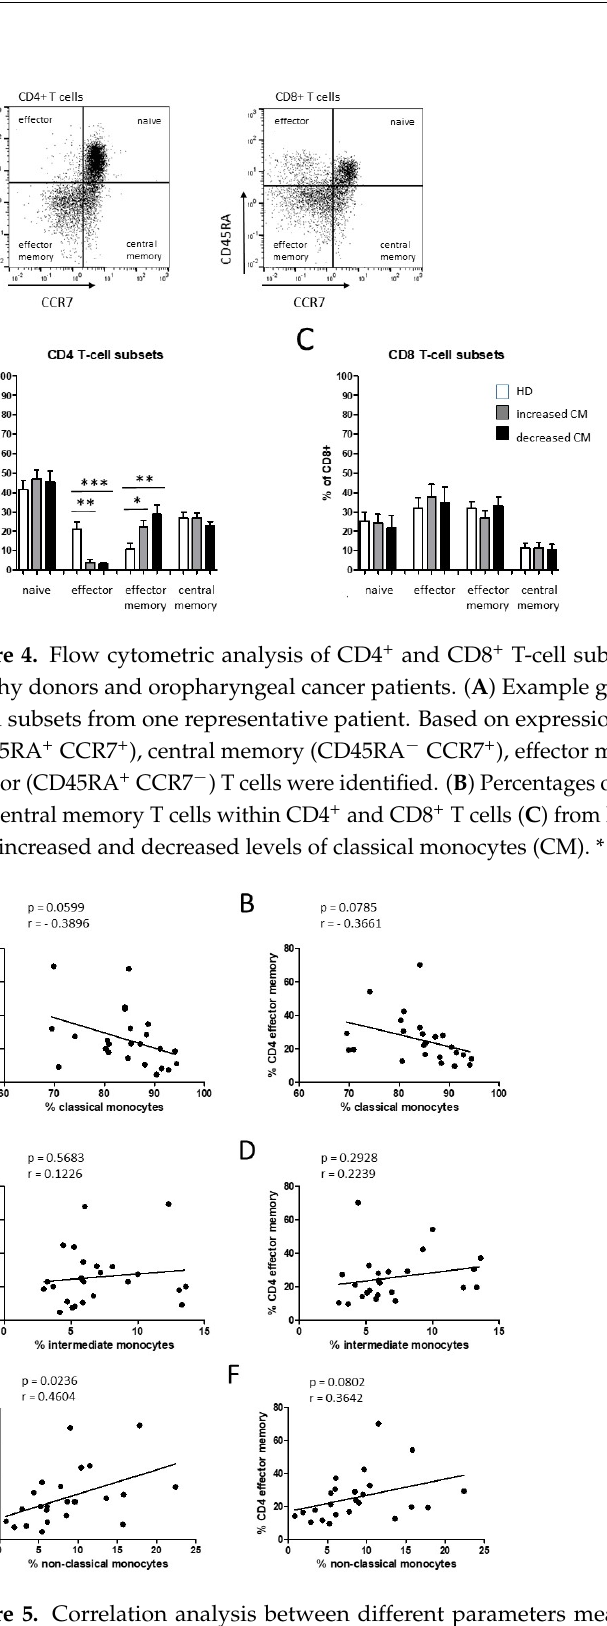
7 of 12 Figure 3. Flow cytometric analysis of CD4 + and CD8 + T cells in PBMCs from healthy donors and oropharyngeal cancer patients. ( A ) Example gating scheme of CD4 + and CD8 + T cells from one rep-